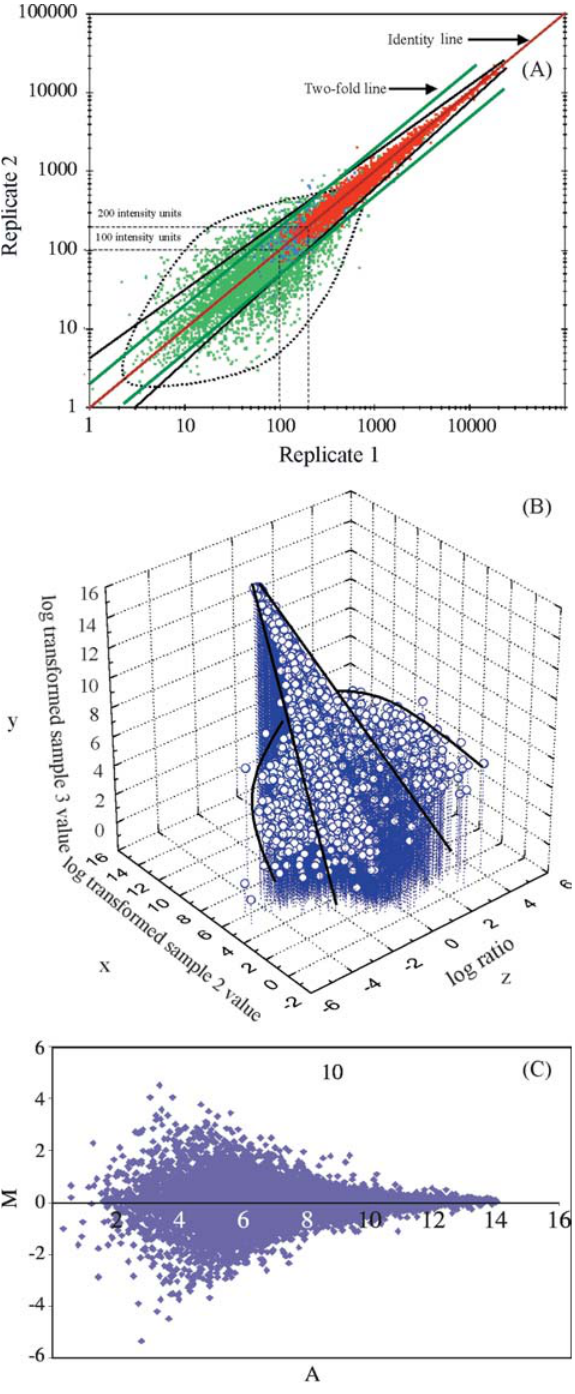
Figure1 -Representativescatterplotoftworeplicateexperiments.(A)A log-scale linear plot where the black lines show that variation is a func- tion of signal intensity for most of the genes while the elliptical line shows that genes with a low signal intensity and absent call do not obey the linear functional relationship. Red dots: present-present plots; Green dots: absent-absent/marginal plots; Blue dots: present-absent/marginal plots. (B) Three-dimensional plot of log transformed signal intensities (x-y axis) and signal log 2 ratios (SLR, z axis). (C) MvA plot (see text for